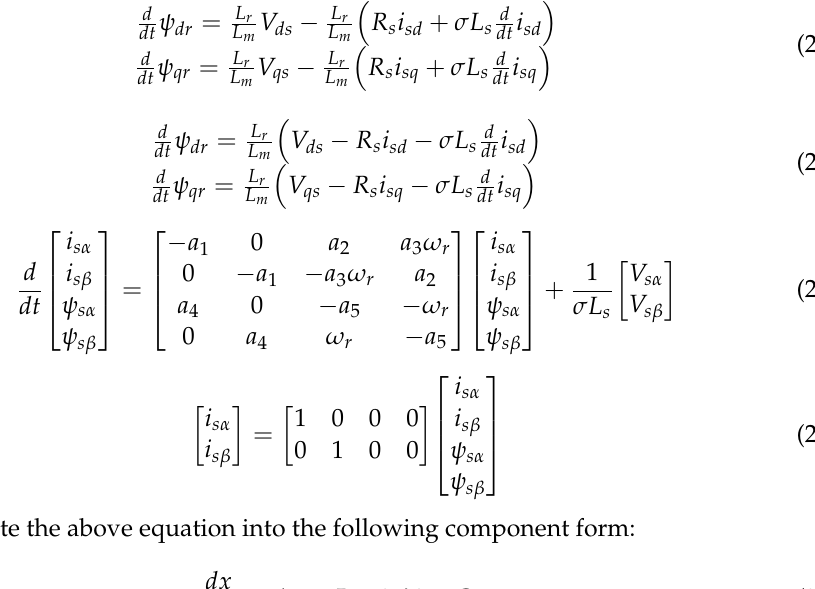
Figure 14. Open loop observer.